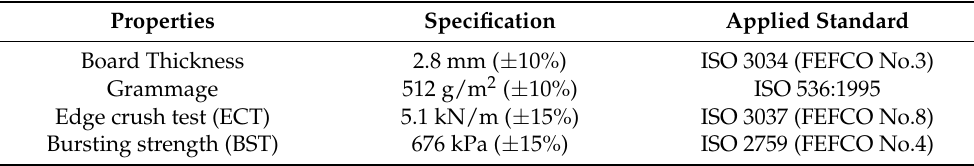
Figure 1. Structure ( a ) and cross-section ( b ) of corrugated cardboard sample used for this study. Table 1. Mechanical specification of the B-flute corrugated cardboard